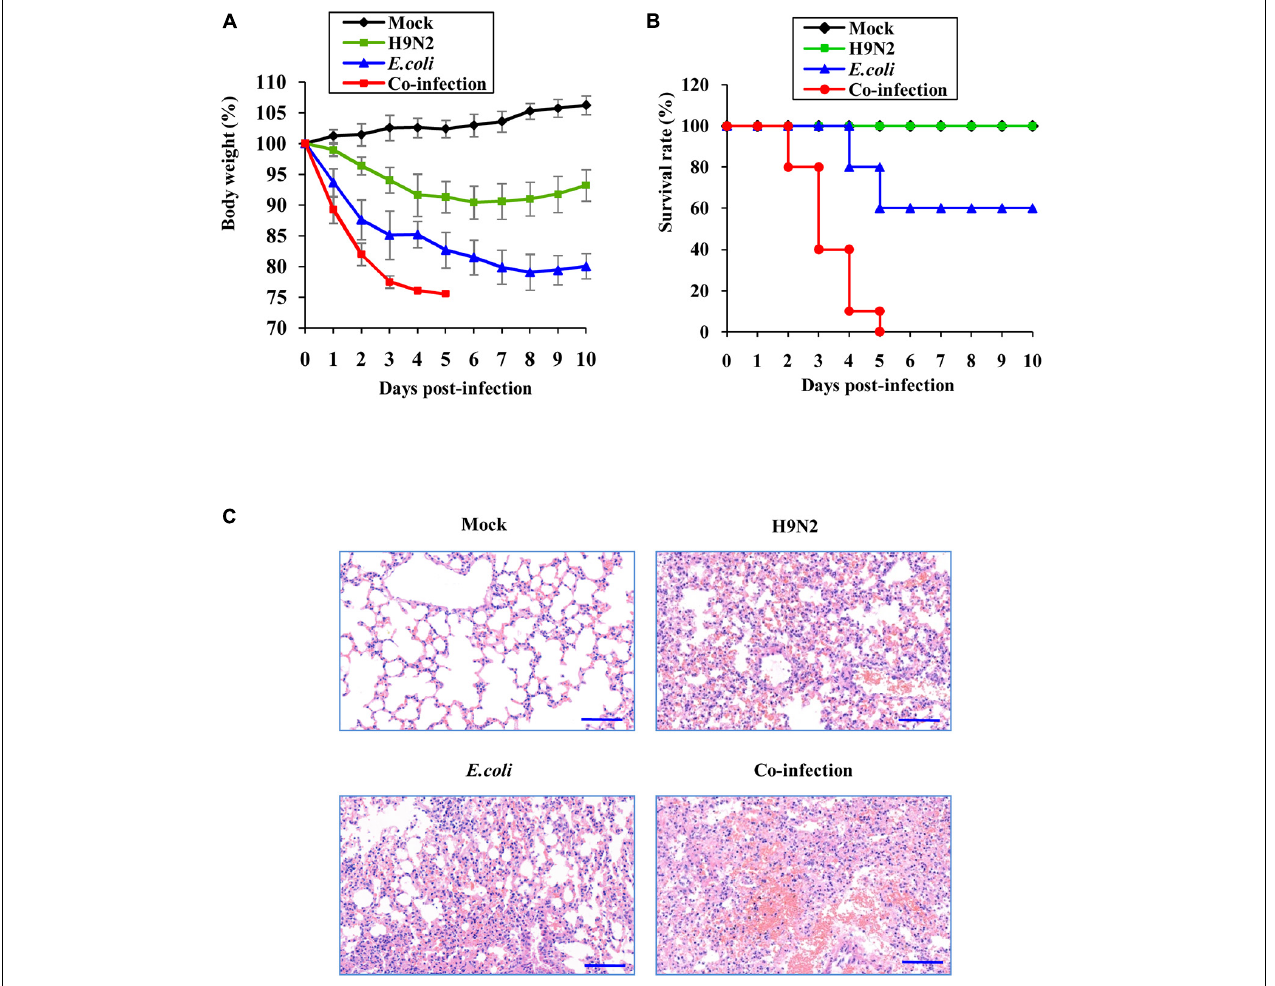
FIGURE 1 | Co-infection of H9N2 AIV and E. coli increases mortality and aggravates acute lung injury. Seven-week-old female SPF BALB/c mice were mock infected, or intranasally infected with single H9N2 AIV (1 × 10 4 PFU) and E. coli (1.5 × 10 7 CFU), or co-infected with H9N2 and E. coli for indicated times ( n = 10 mice/group). (A) The body weight changes of mice in four groups. The results are shown as mean percentage weight changes from three independent experiments. (B) The survival rate of mice in four groups ( n = 10). Mice were monitored for up to 10 days. During this period, mice were sacrificed when they displayed severe unrelieved distress or excessive weight loss (25% weight loss from initial body weight). (C) Representative images (magnification, × 200) of mouse lungs in four groups after 48 h of infection followed by hematoxylin and eosin (HE)